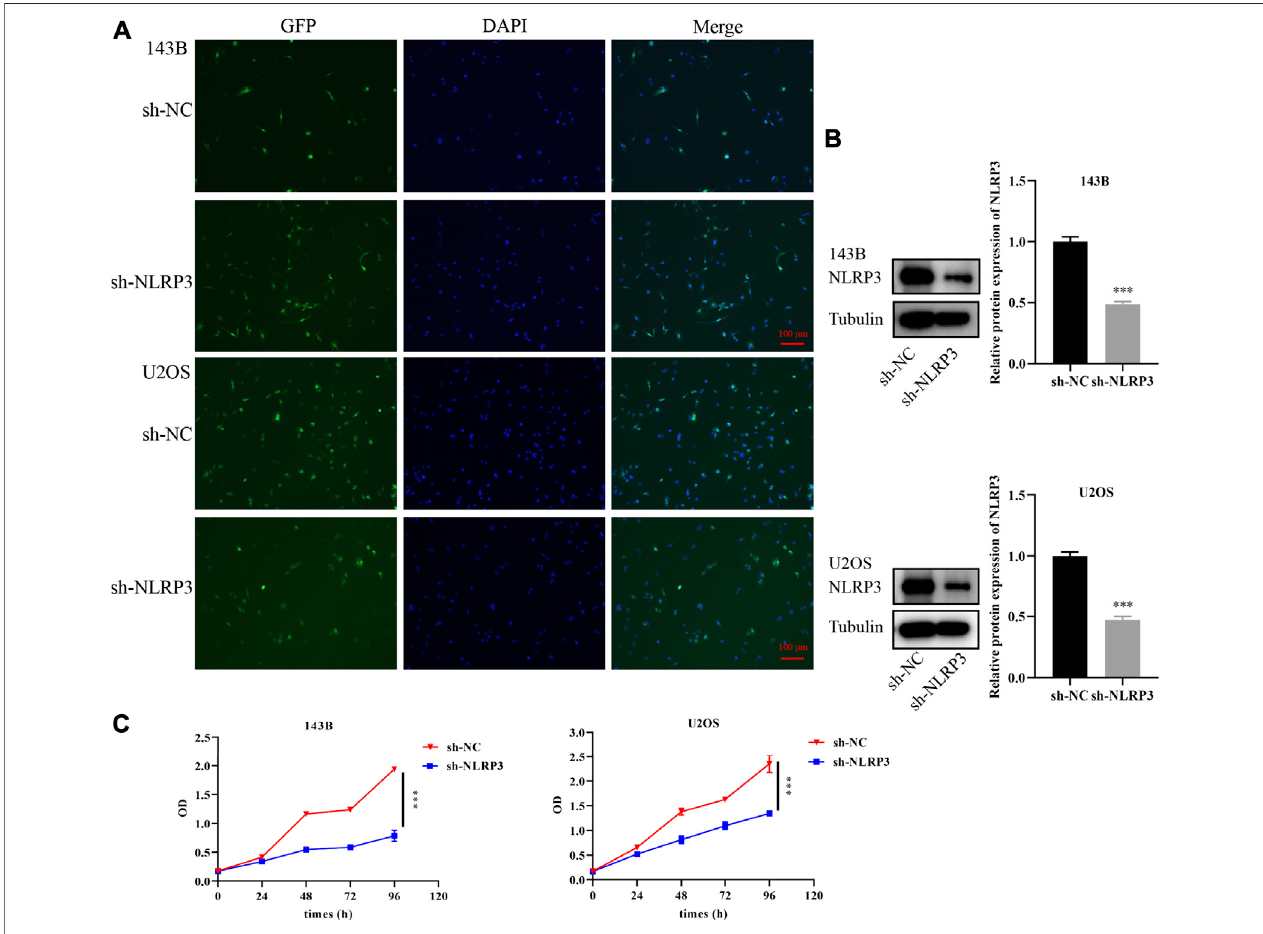
FIGURE 3 | Knockdown of NLRP3 gene and cell viability changes in 143B and U2OS cells (A) Infection ef fi ciency of lentivirus in 143B and U2OS cells (B) Interference effect of143B and U2OS cells veri fi ed by western blot analysis (C) Th changesof cell viability in 143Band U2OS cells after NLRP3 knockdown detected by CCK-8. The experiments were conducted in